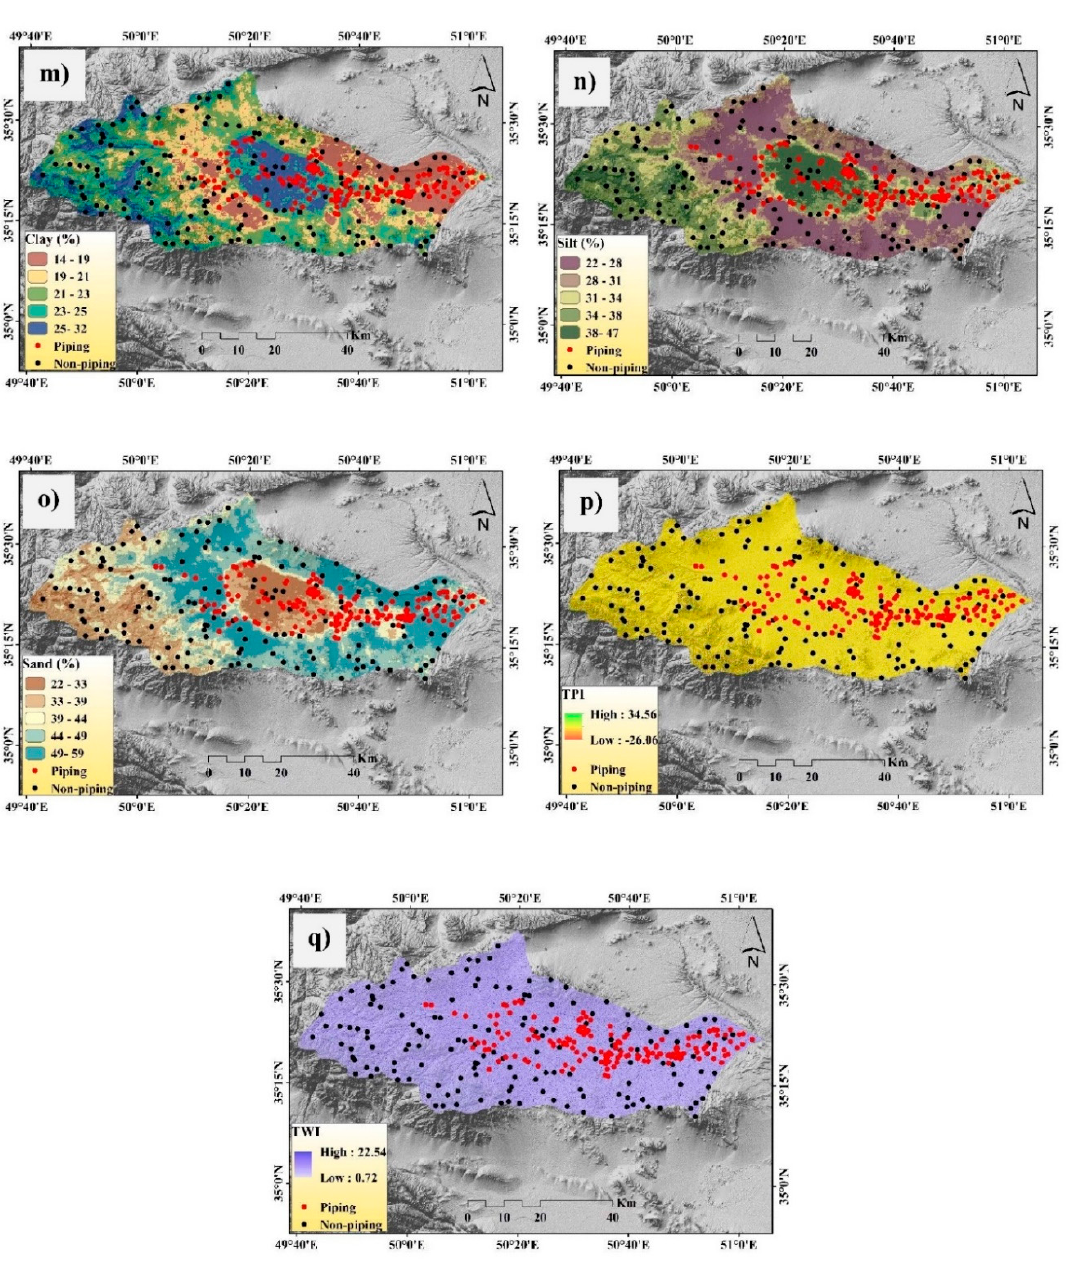
Figure 4. Piping erosion conditioning factors: ( a ) aspect, ( b ) land use, ( c ) lithology, ( d ) altitude, ( e ) rainfall, ( f ) TWI, ( g ) profile curvature, ( h ) distance from river, ( i ) drainage density, ( j ) clay content, ( k ) CEC, ( l ) sand content, ( m ) pH, ( n ) bulk density, ( o ) silt content, ( p ) SPI, ( q ) plan curvature.